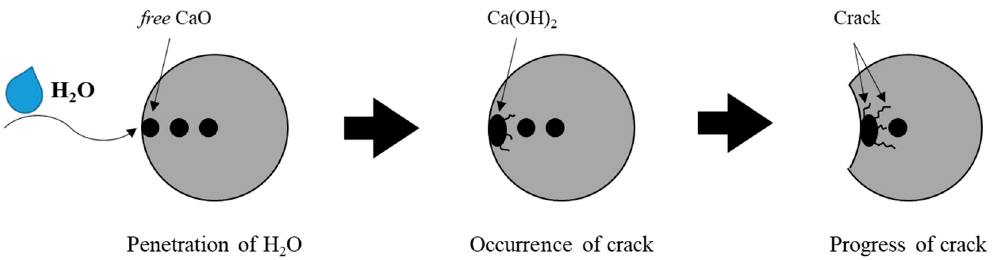
Figure 14. Cracking process of steelmaking slag by free CaO.